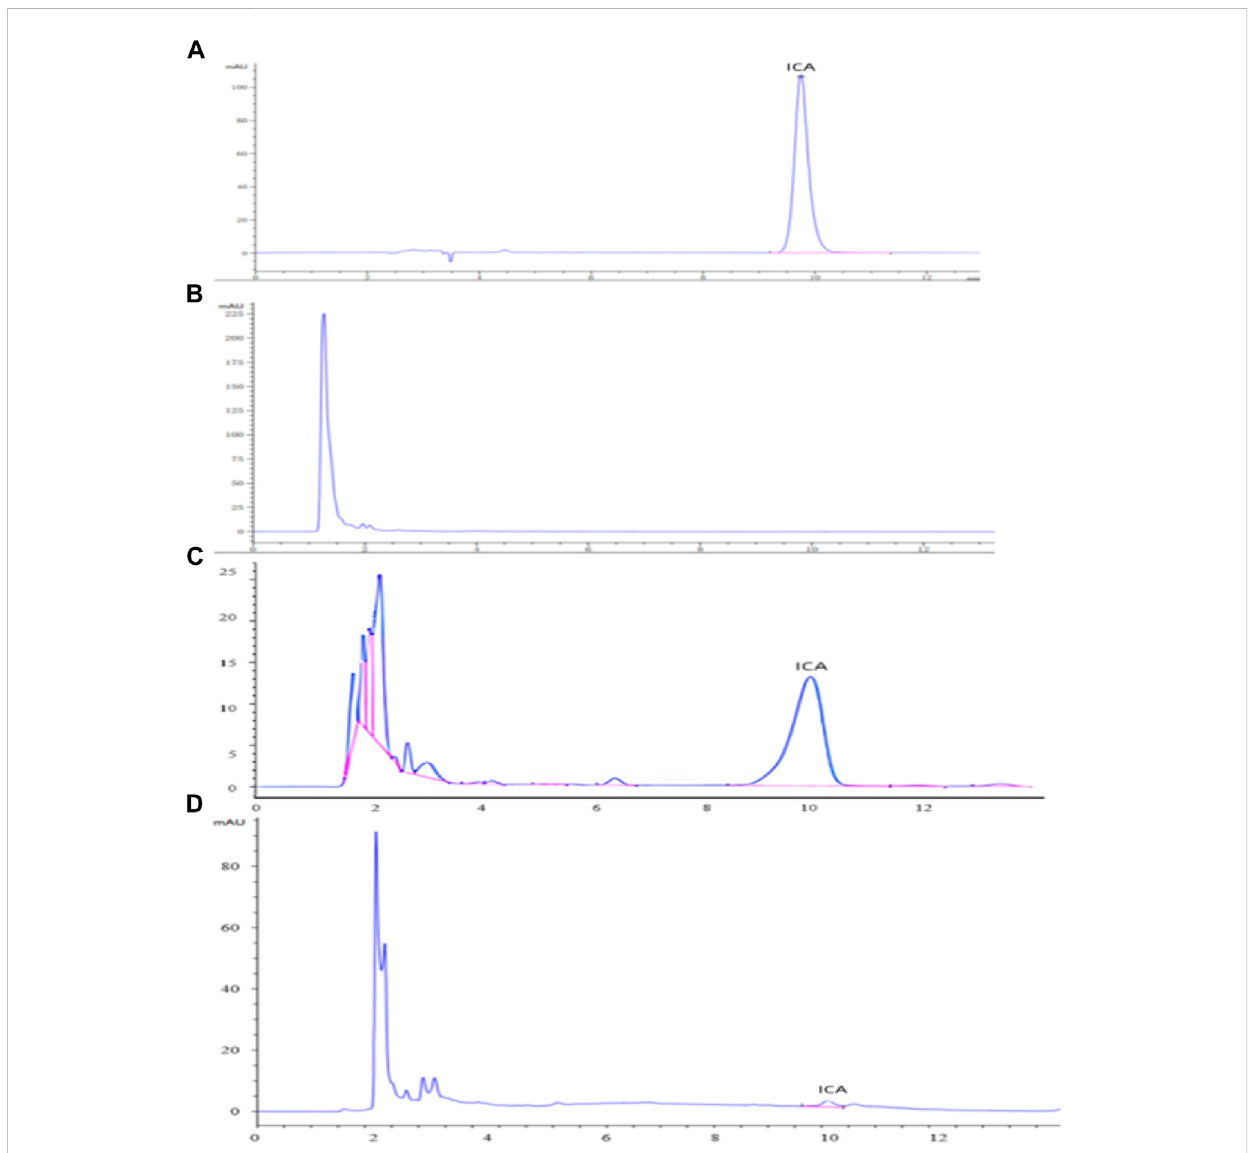
HPLC analysis of icariin (A) , blank dog plasma (B) , plasma containing icariin (C) , and the plasma from the dogs dosed with icariin/ γ -cyclodextrin complex (D)